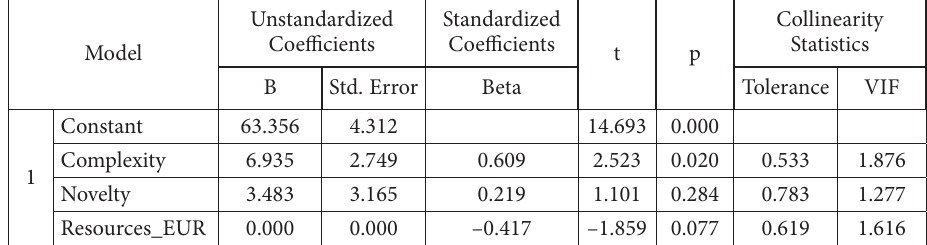
Table 4. Regression coefficient